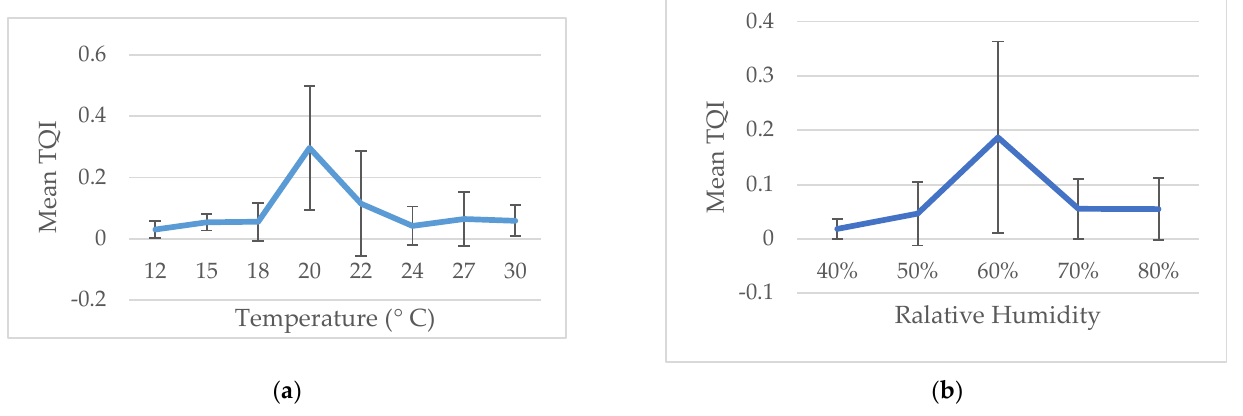
Figure 2. TQI ± SD over environmental conditions during the tick’s collection campaign (2016–2020). ( a ) The influence of temperature on the TQI; ( b ) the influence of RH on the TQI. Error bars represent standard deviations.